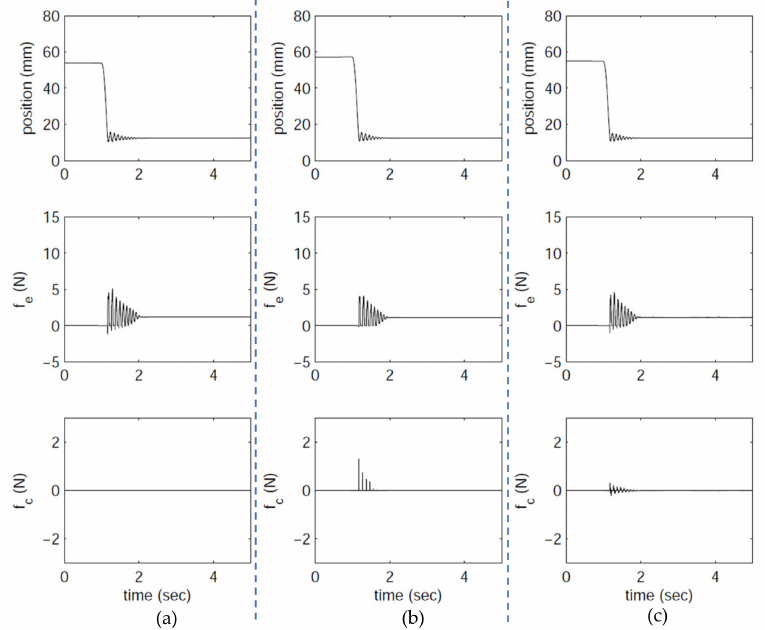
Figure 10. Experimental results at K = 2000 N/m, B = − 5 Ns/m, α = 1 Ns/m: ( a ) controller free, ( b ) the basic passivity controller, and ( c ) the IPC.